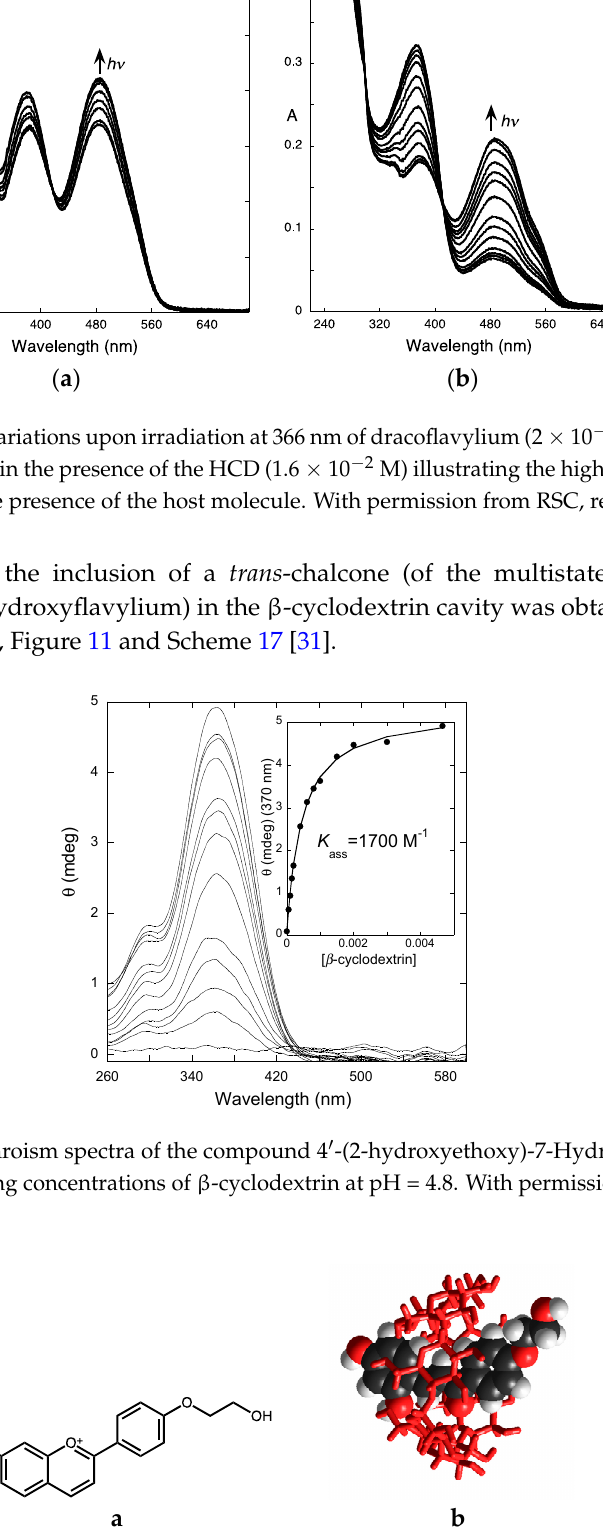
( b ) Figure 10. ( a ) Spectral variations upon irradiation at 366 nm of dracoflavylium (2 × 10 − 5 M) at pH = 4.1; ( b ) the same at pH = 3.1 in the presence of the HCD (1.6 × 10 − 2 M) illustrating the higher photochromic contrast observed in the presence of the host molecule. With permission from RSC, reference [30].